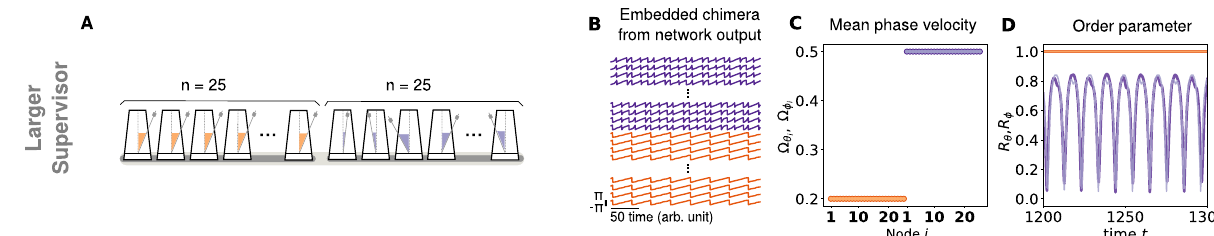
Fig. 4 FORCE method robustness: enforcing a larger supervisor. A Schematic representation of the chimera state with n = 25 in each group: each metronome represents an oscillator with phase θ i (light orange or light gray for b/w printing, synchronous group) or ϕ i (light purple or dark gray for b/w printing, asynchronous group). B Embedded chimera from the network output using a larger supervisor. C Mean phase velocity pro fi le for the embedded chimera (bright colors) obtained from the network output using a larger supervisor (light colors). D Order parameter trajectory for the embedded chimera (bright colors) obtained from the network output using a larger supervisor